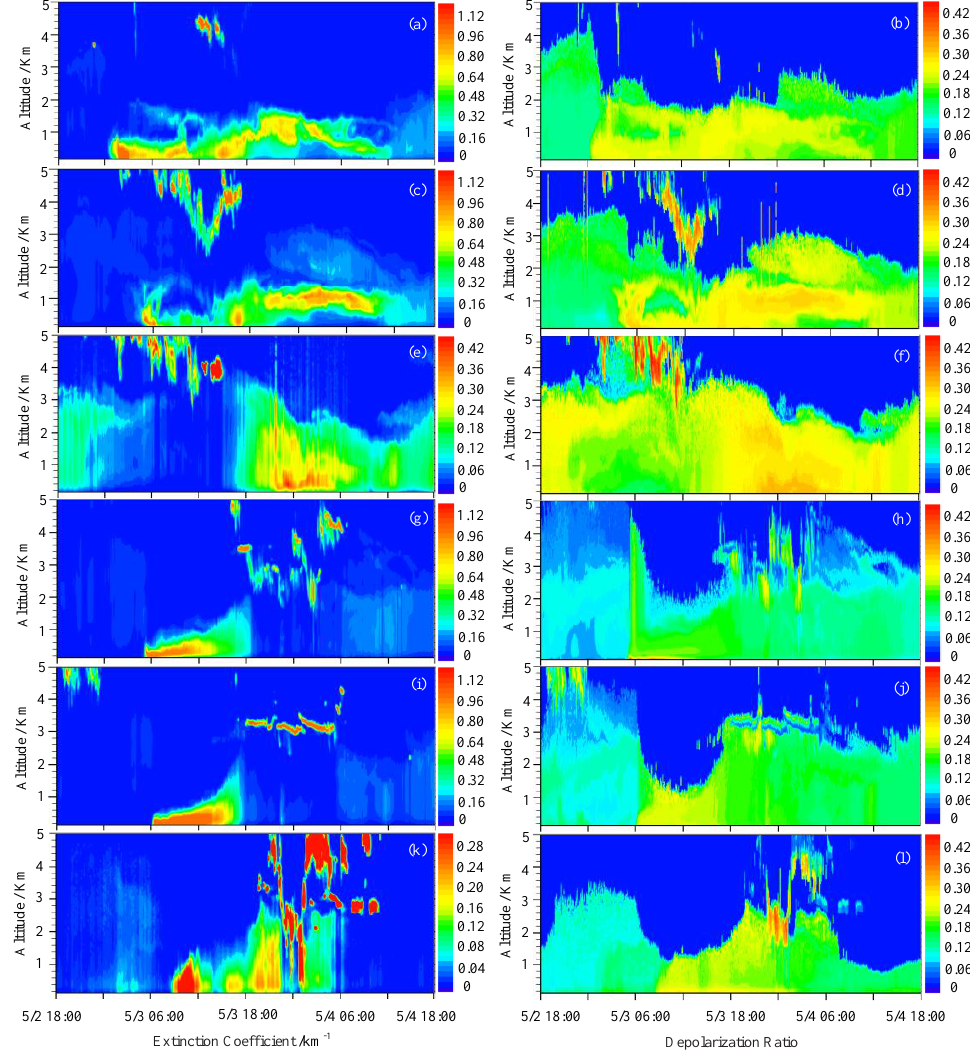
Figure 6. Vertical structure of aerosols from Lidar observation in different cities. Left panel: extinction coefficient of 532 nm, right panel: depolarization ratio of 532 nm. (From top to bottom: Jiayuguan ( a ), ( b ), Yumen ( c ), ( d ), Aksay ( e ), ( f ), Jinchang ( g ) ( h ), Wuwei ( i ), ( j ), Baiyin ( k ), ( l )).